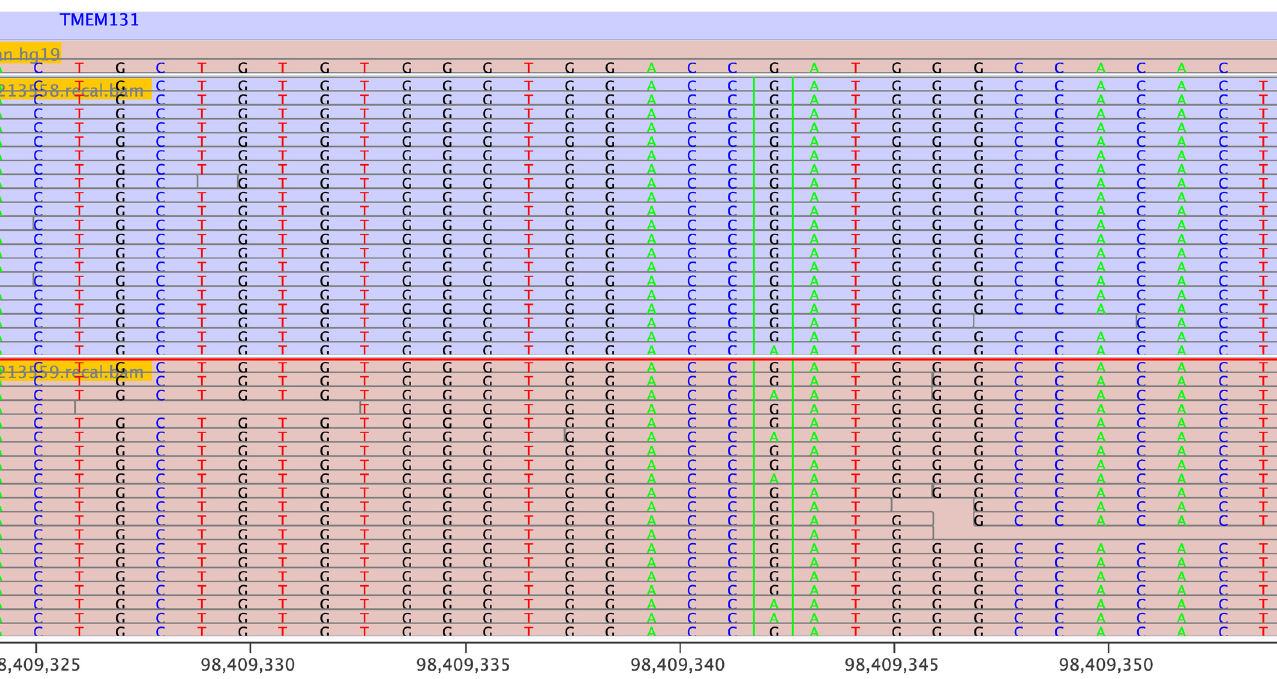
(60.7%) were identified by both software. A validated RNA-editing site (chr2:98409343 in TMEM131 ) identified by RED is shown in Fig 4.